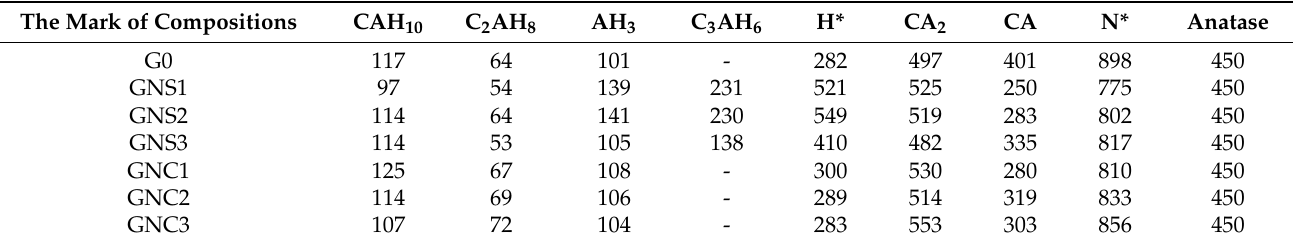
Figure 7. X-ray diffraction patterns of the cement pastes (with and without NC and NS) after 3 days of hardening (20 °C). Table 3. The intensity of the main peaks of minerals.